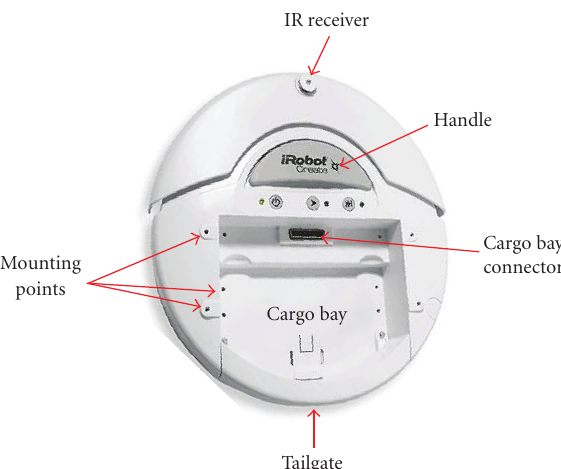
Figure 1: iRobot Create from iRobot, Inc. [5].